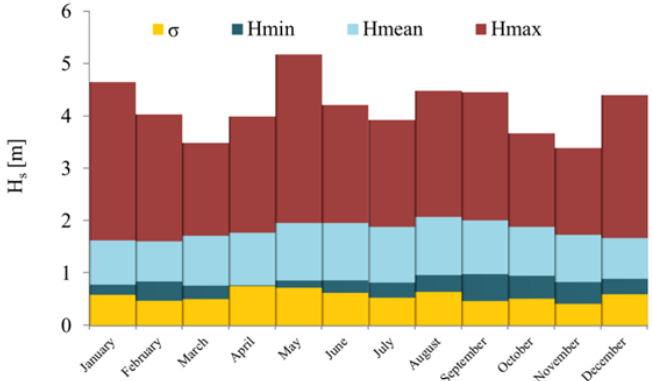
Figure 6. Monthly wave climate characterization, in terms of significant wave height, averaged over 10 years at point P16.